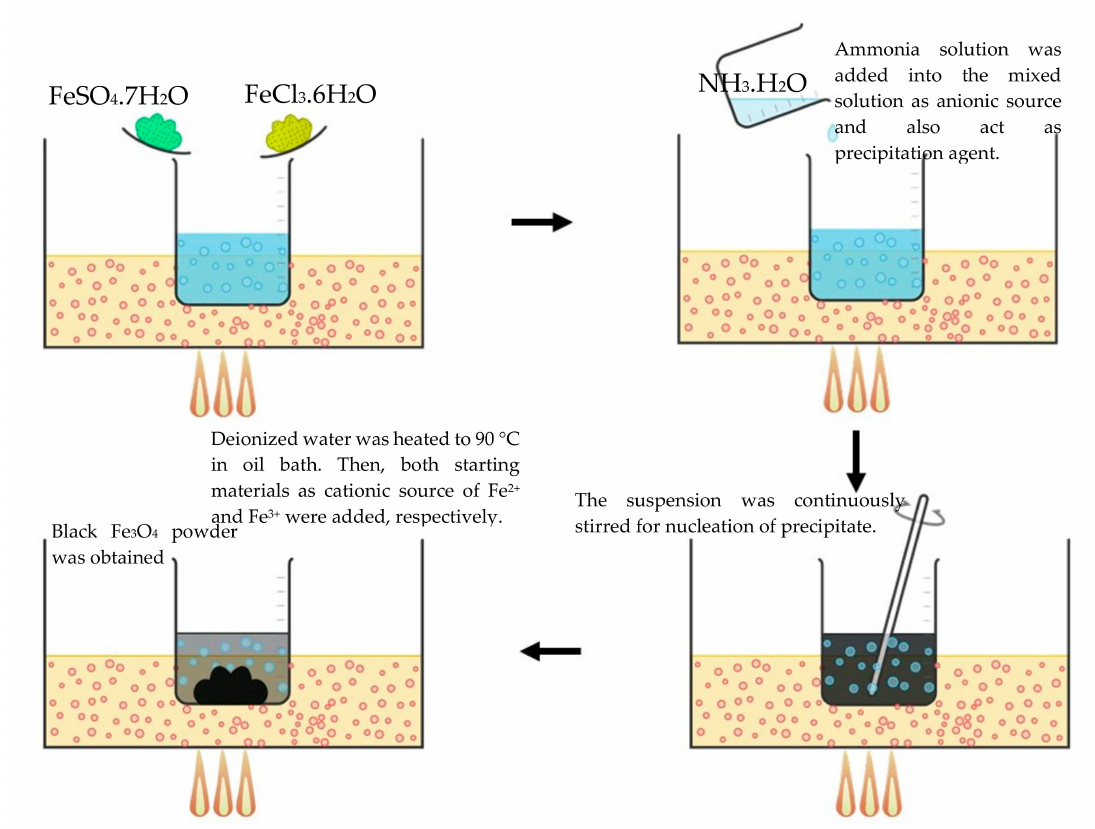
Figure 15. Illustration of the preparation of Fe 3 O 4 by the co-precipitation